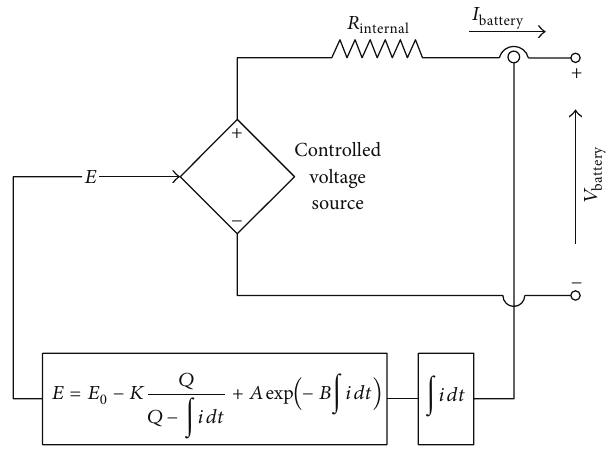
Figure 9: Nonlinear standard battery model [31].